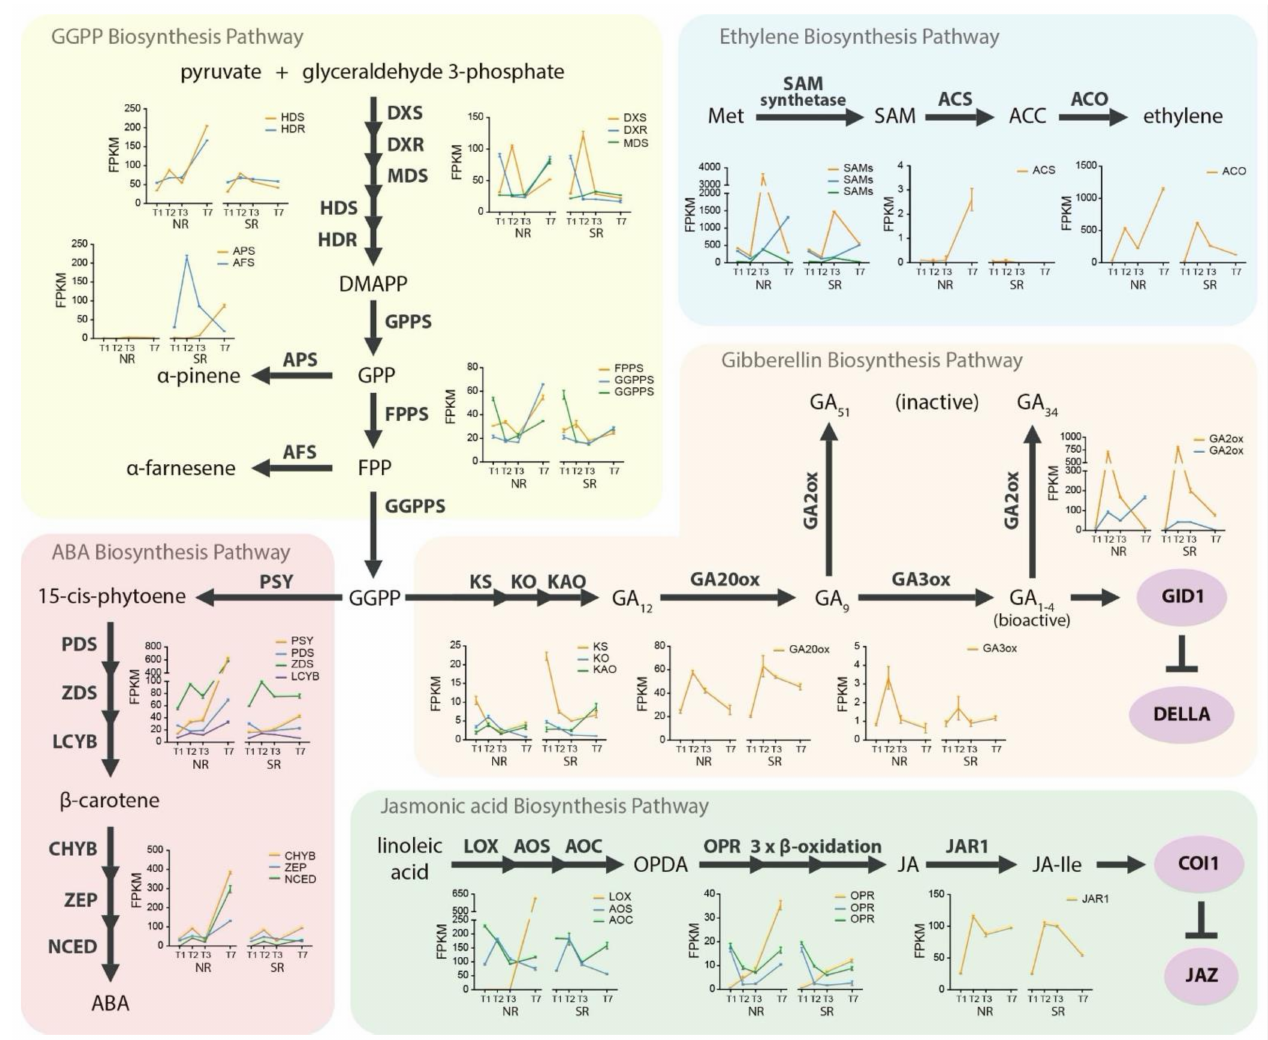
Figure 3. Graphical representation of hormone biosynthetic pathways related to fruit development. Schematic dia- gram of different hormone biosynthetic pathways related to fruit development are represented in separated colored boxes. Each transcript involved in a specific hormone biosynthetic step is in bold, and their expression profiles are represented in different graphs only for genes with differential expression identified by RNAseq with FDR < 0.05 and FC > |1|. The expression profiles of the NR and SR transcripts are represented on the left and right side of each graph, respectively. DXS, 1-deoxy-D-xylulose-5-phosphate synthase; DXR, 1-deoxy-D-xylulose-5-phosphate reductase; MDS, 2-C-methyl-D-erythritol 2,4-cyclodiphosphate synthase; HDS, hydroxymethylbutenyl 4-diphosphate synthase; HDR, hy- droxymethylbutenyl 4-diphosphate reductase; DMAPP, dimethylallyl pyrophosphate; GPP, geranyl diphosphate;